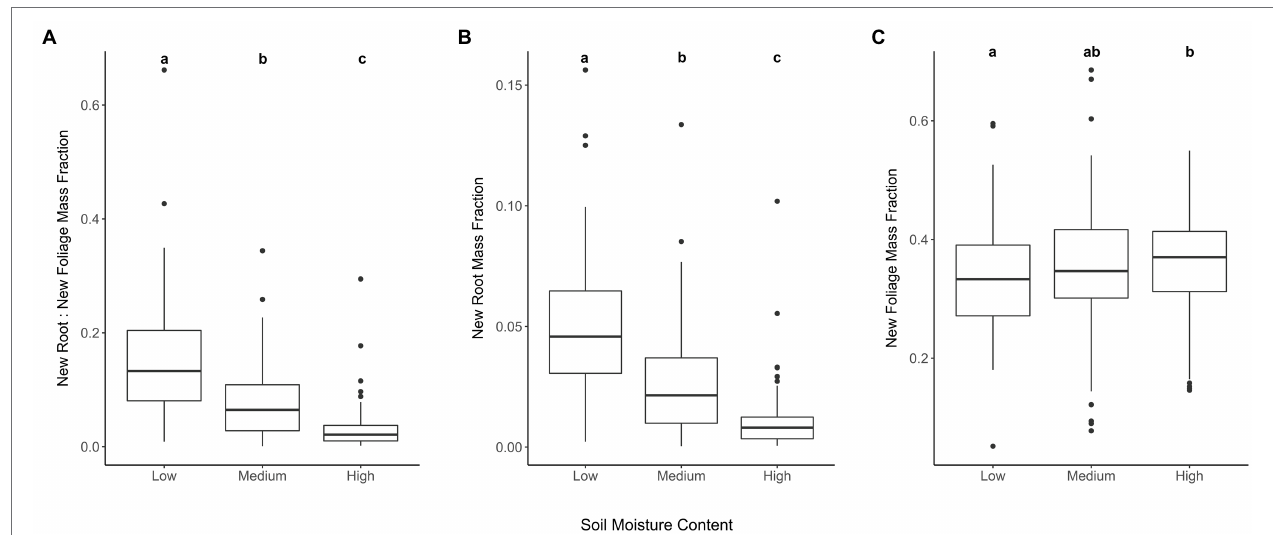
FIGURE 1 | New root and foliage tissue biomass responses to drought preconditioning soil moisture contents. Ratio of new root to new foliar tissue biomass (A) . Seedling root biomass (B) and foliage (C) produced during RGP trial standardized by total seedling biomass prior to RGP trial. Treatment levels that do not share lower-case letters within a panel are significantly different based on Tukey’s HSD pairwise comparisons ( p < 0.05).